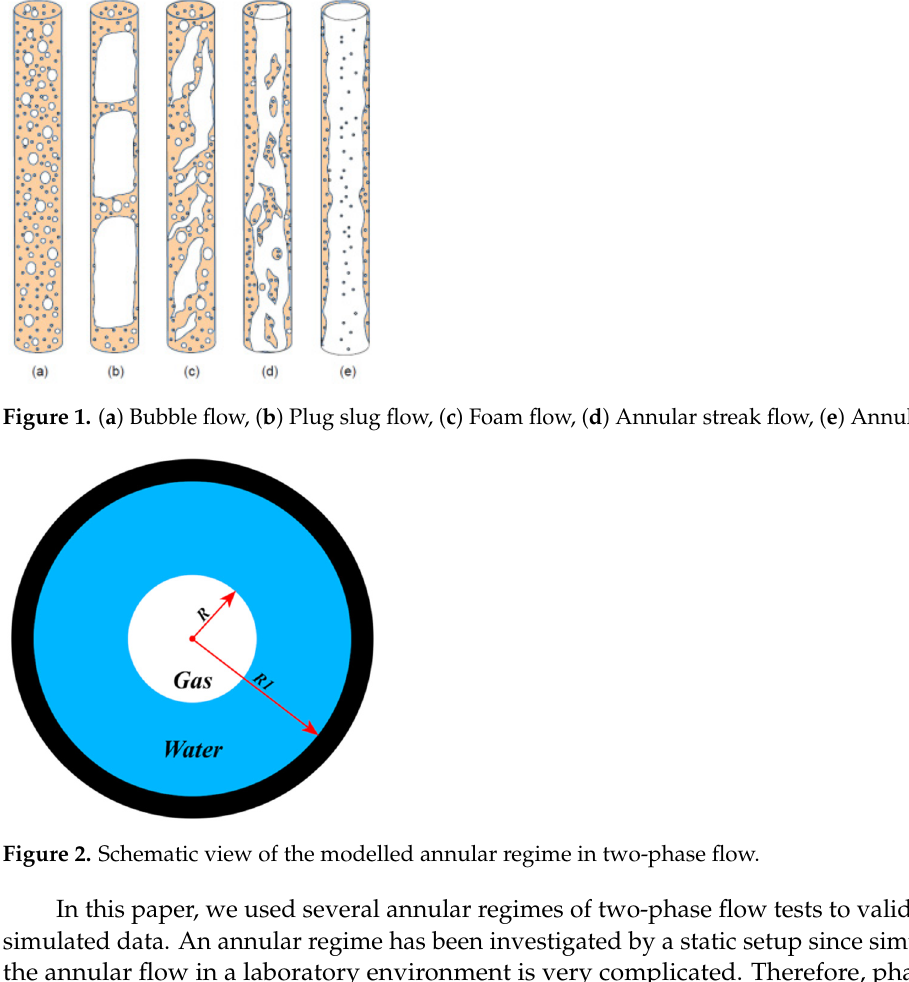
Figure 2. Schematic view of the modelled annular regime in two-phase flow.